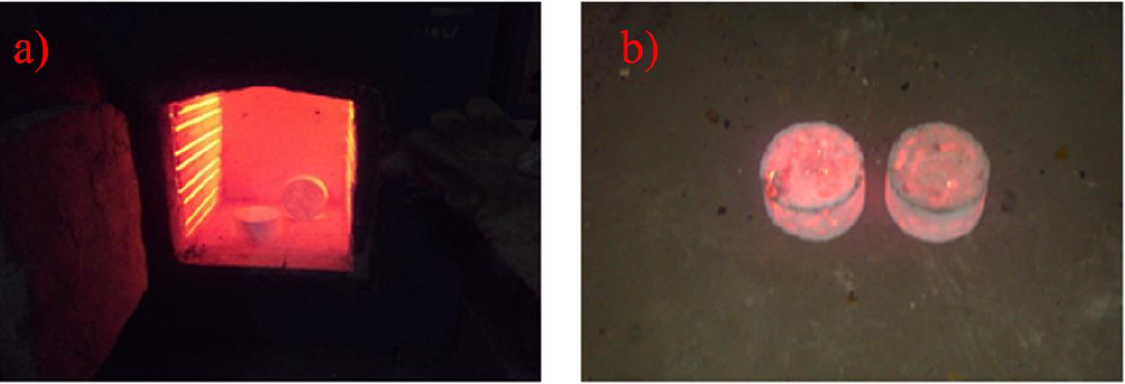
Figure 1. Photos of heated specimens. ( a ) Impact specimen under temperature exposure in furnace. ( b ) Air cooling of impact